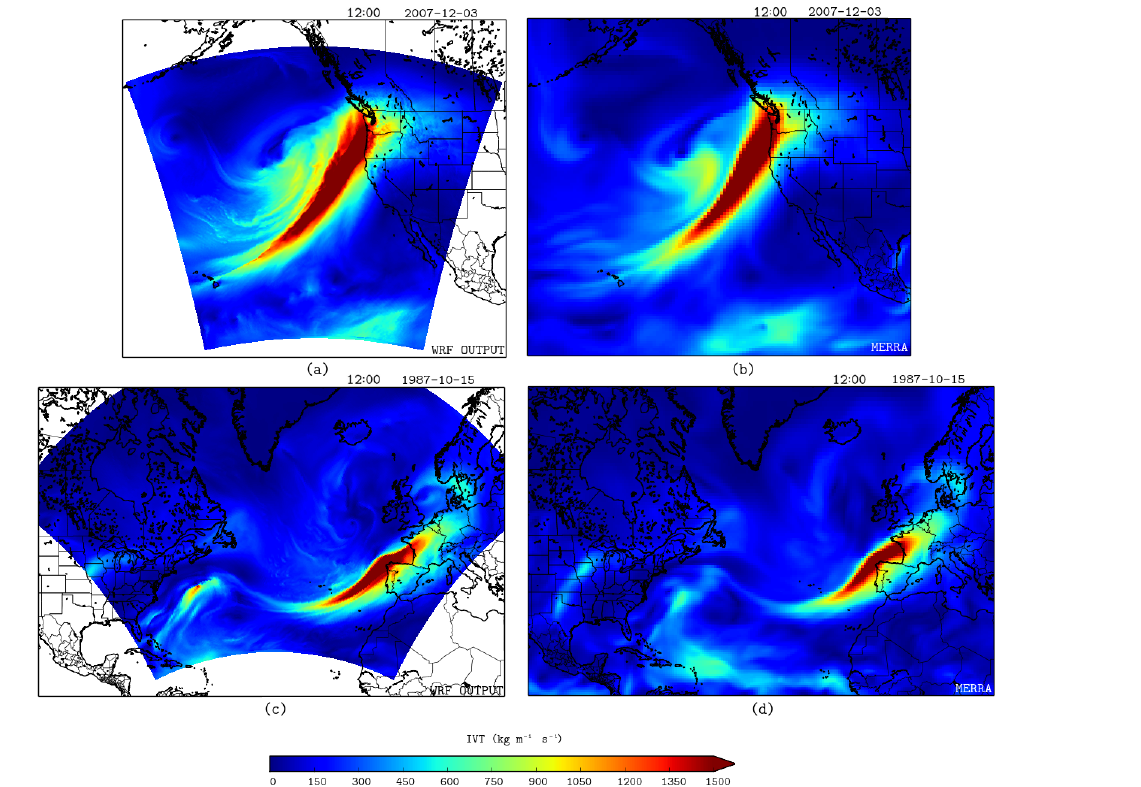
Figure 4. Absolute value of IVT in kilograms per meter per second for the Pacific event from WRF (a) and MERRA (b) as well as for the Atlantic event from WRF (c) and MERRA (d)